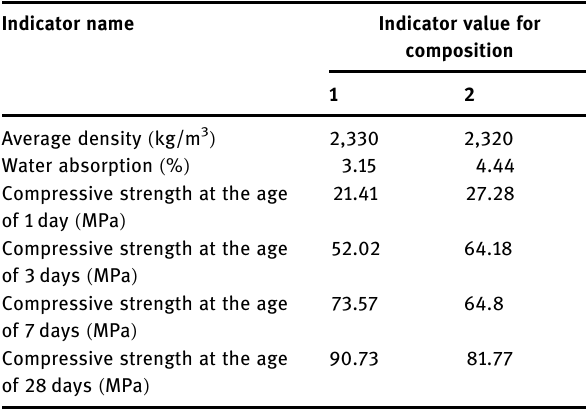
Table 20: Physical and mechanical properties of nano - modi fi ed